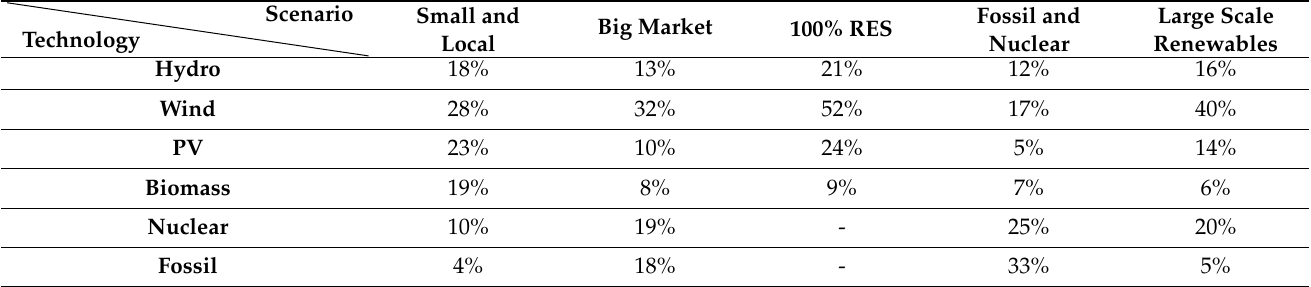
Table 3. Generation mix (% of total) for the five contrasted decarbonized scenarios [35]. Technology